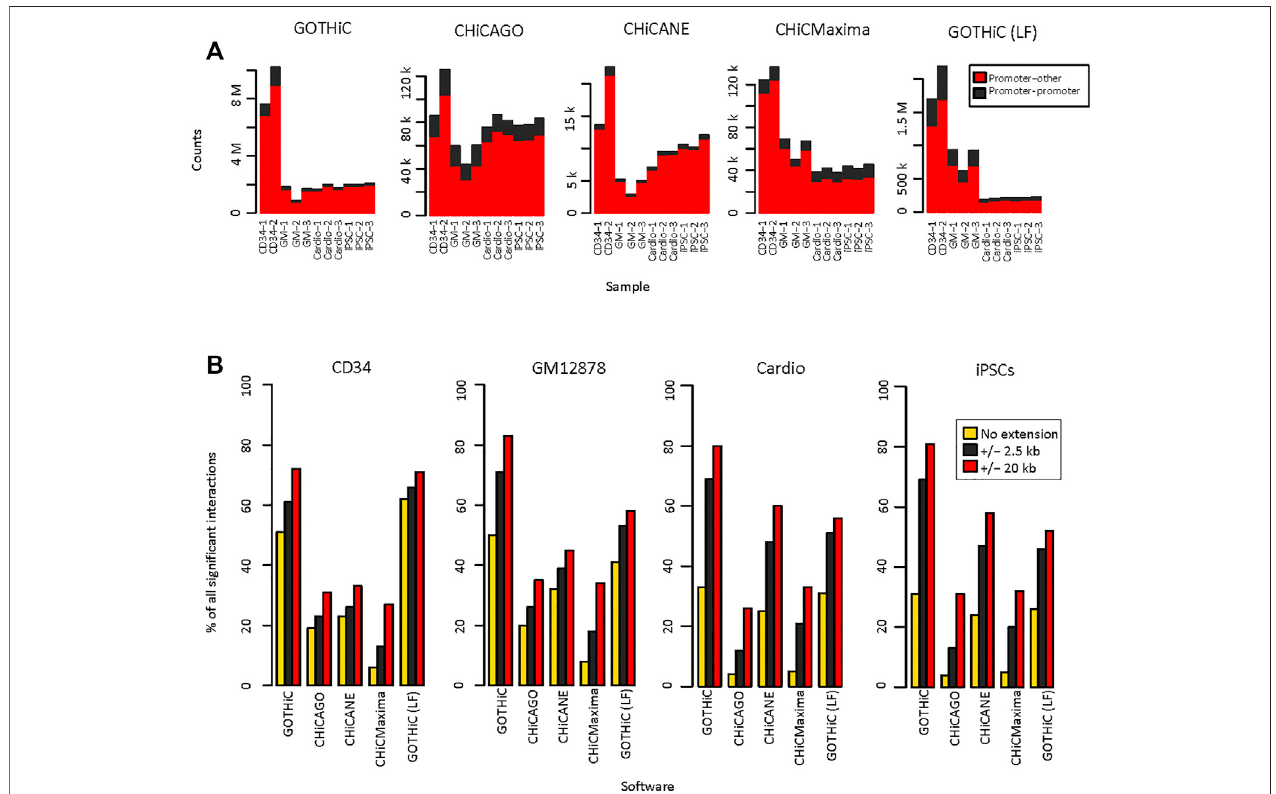
FIGURE 3 | Reproducibility of HiCUP-preprocessed signi fi cant interactions. (A) . Number of HiCUP-preprocessed signi fi cant interactions using GOTHiC (with and withoutLF),CHiCAGO,CHiCANE andCHiCMaxima. (B) .Barplotsrepresent thepercentage ofnon-baitedfragmentsthatoverlapinatleasttworeplicatesforeach bait. Overlaps were studied for exact fragment-level interactions and interactions where non-baited fragment-ends were extended by 2.5 kb or 20 kb.